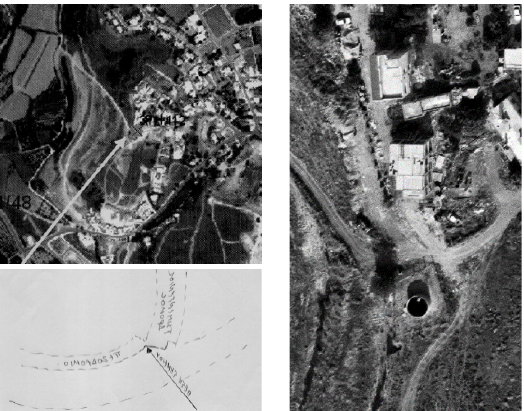
Figure 5. Example of barely visible GCP (left images) in historical images (Cyprus, 1993).